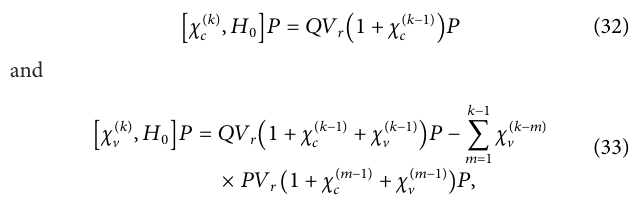
Table 11. Here, the correlated orbitals are divided into fi ve subsets I-V, which correspond to the core (1 s , 2 s , 2 p , and 3 s ), the valence (3 p ), and the rest (virtual) orbitals, receptively. The ‘ minimal ’ (min) and ‘ maximal ’ (max) number of electrons (min, max) in the I, II, and III types of space are (2, 4), (6, 8), and (10, 12), respectively. That is to say, only single and 3 p (space IV) are included, at most three electrons are allowed to excite